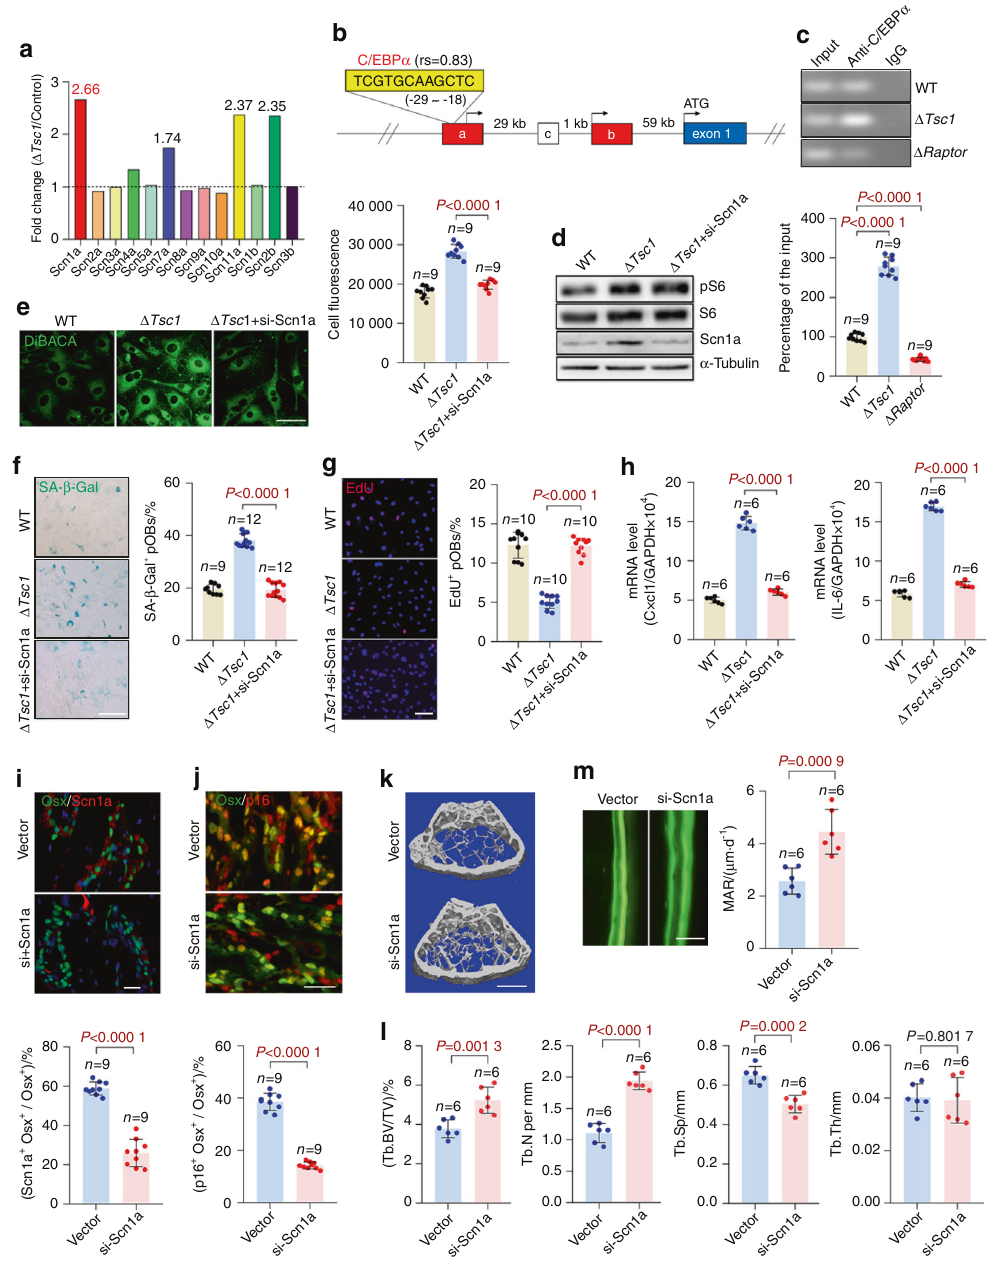
Fig. 6 The sodium channel Scn1a mediates plasma membrane depolarization in senescent preosteoblasts. a mRNA expression of voltage-sensitive sodium channels in the Δ Tsc1 and control calvarial preosteoblasts indicated by our previous global mRNA expression pro fi le (GSE74781). b Binding site of C/EBP α in the 5 ′ -UE of Scn1a (yellow box) predicted by the JASPAR database (http://jaspar.genereg. net). rs: JASPAR relative scores, which are de fi ned as 1 for the maximum-likelihood sequence. Boxes represent exons: blue coding exons, red noncoding exons conserved between humans and mice, white noncoding exons identi fi ed in either human or mouse transcripts. Noncoding exons are named alphabetically, and the fi rst coding exon (exon 1) of the Scn1a gene is indicated. Genomic distances between exons are indicated. c Binding of C/EBP α to the 5 ′ -UE sequence of Scn1a in vivo, determined by a ChIP assay using the Δ Tsc1 and Δ Raptor cells and anti-C/EBP α antibody or IgG. The ChIP samples were then subjected to qPCR with the Scn1a 5 ′ -UE primers. The percentage of the input of the sample by using the anti-C/EBP α antibody in the wild-type cells was normalized to 100. The Δ Tsc1 osteoblasts were transfected with Scn1a siRNA and subjected to ( d ) Scn1a detection with western blotting, ( e ) measurement of relative plasma membrane potential with DiBAC4 dye, ( f ) SA- β -gal staining and quanti fi cation of the proportion of SA- β -gal-positive cells, ( g ) immunostaining of EdU and quantitative analysis of EdU + cells relative to total cells, and ( h ) qPCR analysis of IL-6 and Cxcl1 mRNA. Double immunostaining of Osx plus Scn1a ( i ) and Osx plus p16 ( j ) in the tibias of the 18-month-old Δ Tsc1 mice injected with adenovirus encoding si-Scn1a for 1 month. Double positively stained cells were quanti fi ed. Representative μ CT images ( k ) and quanti fi cation of trabecular bone ( l ) in the mice. ( m ) Representative images of calcein labels and quanti fi cation of the mineral apposition rate (MAR) in femurs from the 18-month-old Δ Tsc1 mice receiving si-Scn1a. Scale bars: 50 μ m in e , g , m ; 100 μ m in i , j ; and 500 μ m in k . Data are shown as the mean ± SD. The numbers of samples ( n ) are indicated in each fi gure panel. P values were determined with two-tailed Student ’ s t test for single